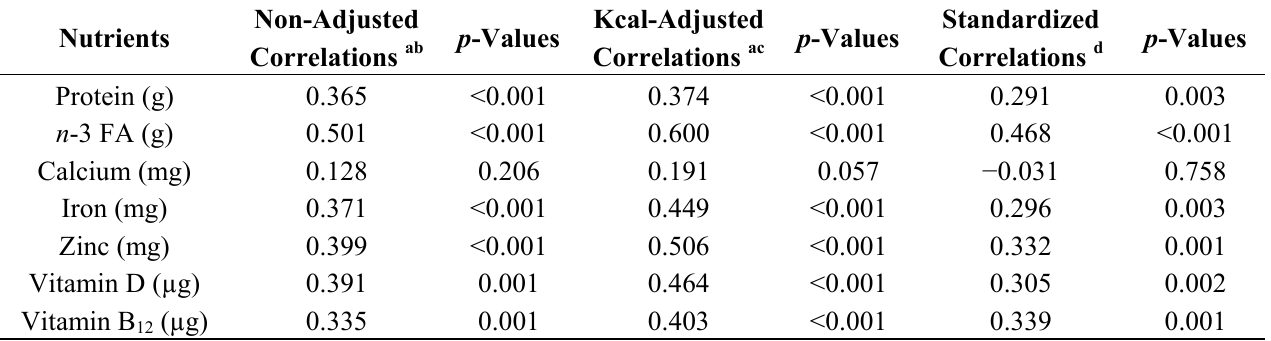
Table 2. Correlation coefficients for nutrient intakes from the vegan food frequency questionnaires (FFQ) and three 24-h diet recalls.